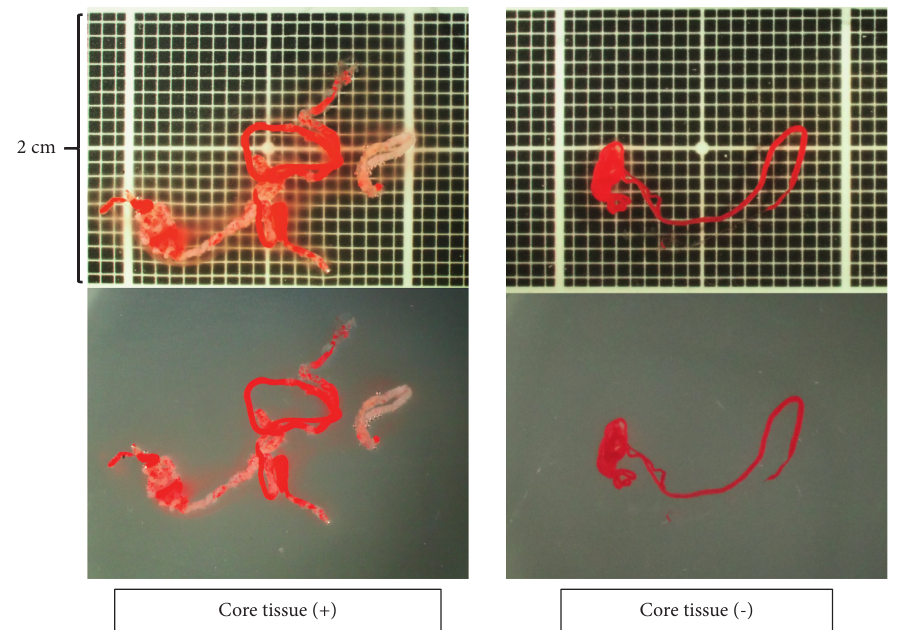
Figure 2: Macroscopic on-site evaluation using a stereomicroscope. The observation screen was set up with a vertical width of 2cm with a scale of 1 mm behind it. The quality of the specimen is evaluated with nothing behind